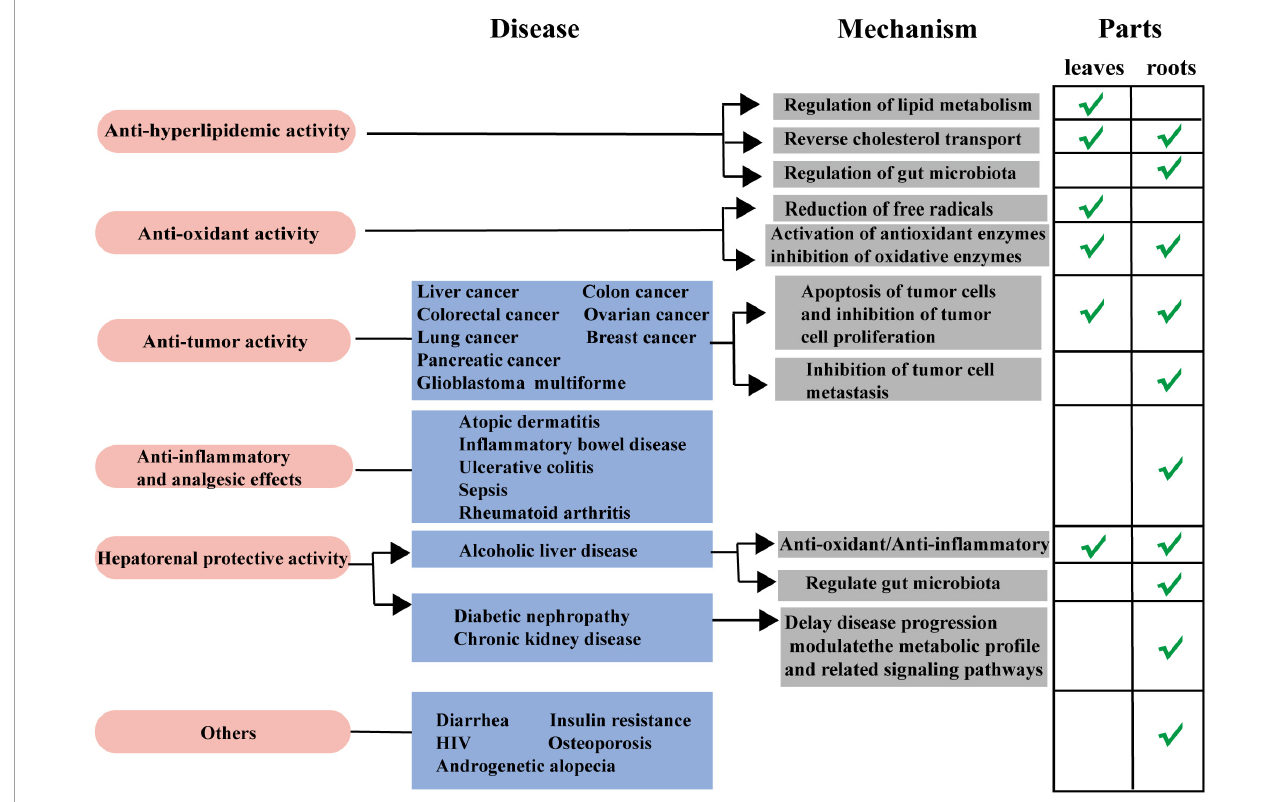
FIGURE5 Schematic diagram of pharmacological activities from the roots and leaves of L.